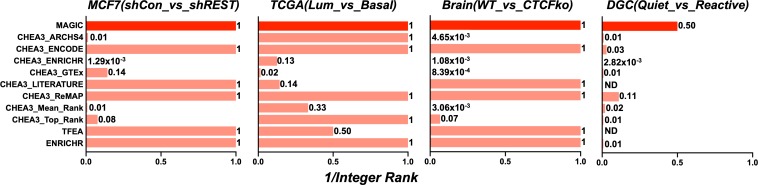
Comparing ranks of manipulated factors predicted by MAGIC, CHEA3, TFEA and Enrichr.MCF7(shCon_vs_shREST), TCGA(Lum_vs_Basal), Brain(WT_vs_CTCFko) and DGC(Quiet_vs_Reactive) datasets were analyzed by MAGIC, CHEA3 (using all available libraries: ARCHS4 co-expression, ENCODE ChIP-Seq, Enrichr Queries, GTEx co-expression, Literature mining, ReMAP ChIP-seq, Mean Rank and Top Rank), TFEA and Enrichr. The reciprocal integer ranks for REST, ESR1, CTCF and FOS (the Factors manipulated in MCF7(shCon_vs_shREST), TCGA(Lum_vs_Basal), Brain(WT_vs_CTCFko) and DGC(Quiet_vs_Reactive)) are plotted. The top rank = 1, second rank = 0.5 etc. ND = Not Determined; Factor not present in library.